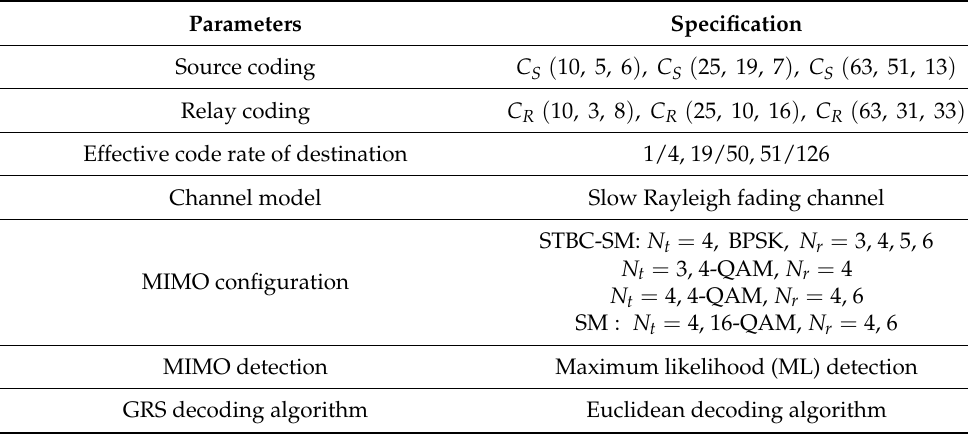
Table 9. Parameters utilized in the